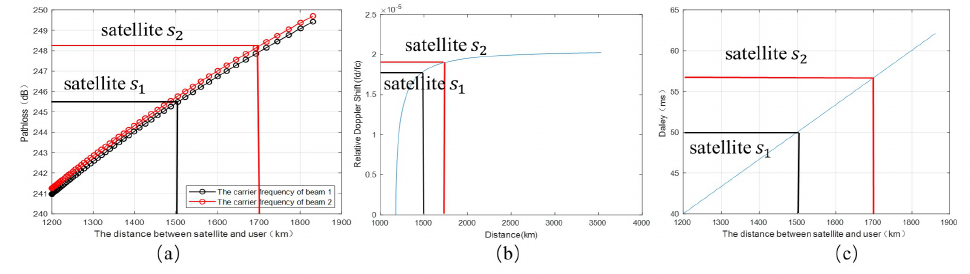
Figure 4. ( a ) Free space fading model. ( b ) Doppler shift model. ( c ) Transmission delay